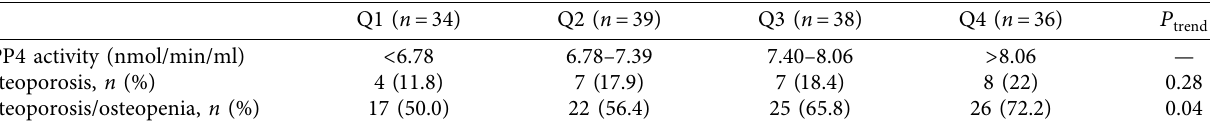
Table 2: Prevalence rate of osteoporosis/osteopenia according to plasma DPP4 activity quartiles.